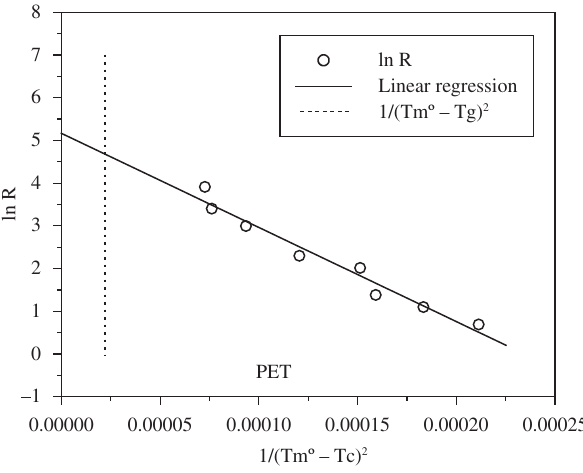
Figure 4. Fitting of the crystallization data to Equation 1 for obtaining the critical cooling rate for vitrification of PET. Dotted vertical line represents the undercooling associated